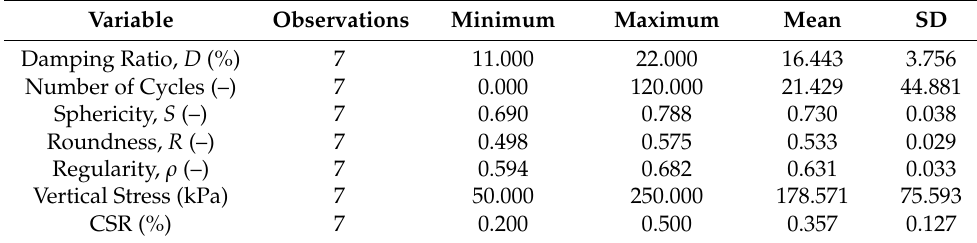
Table 5. Descriptive statistics for the testing dataset.